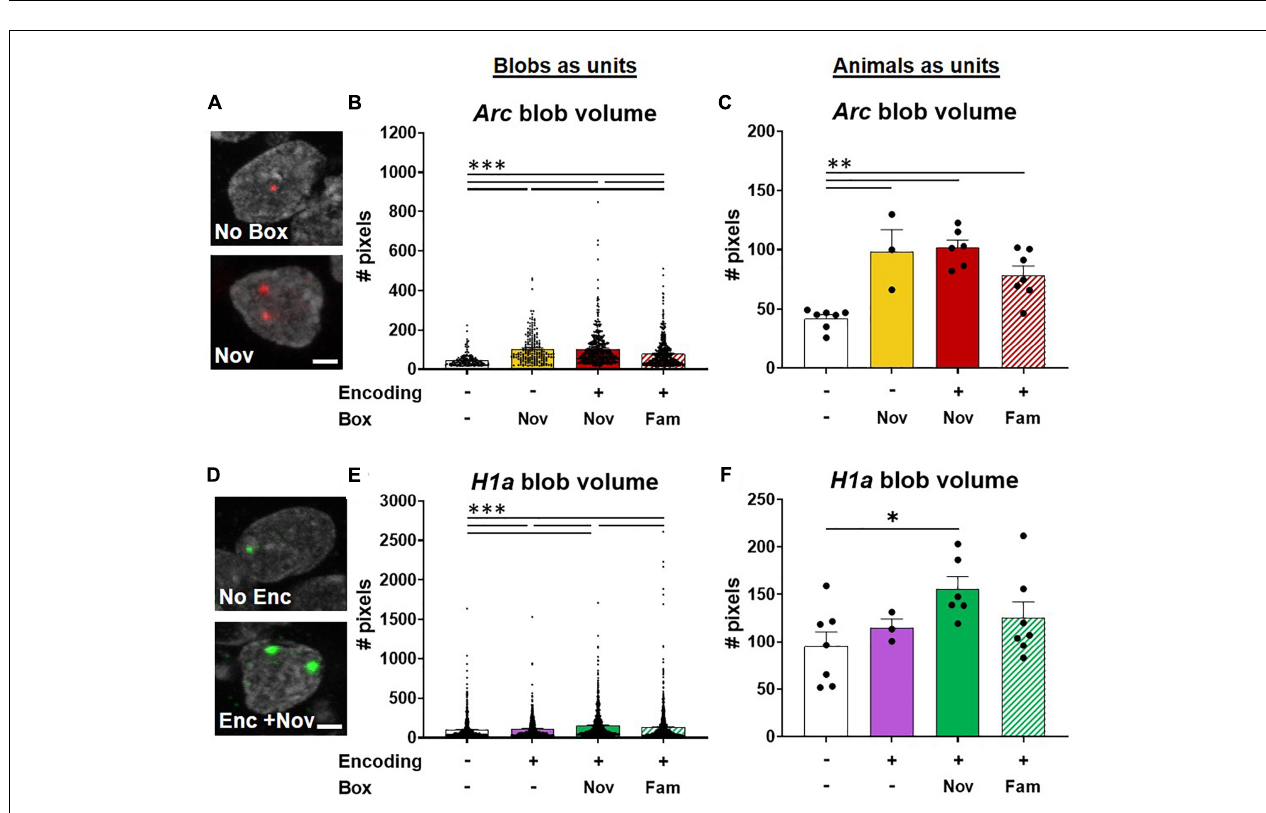
FIGURE 6 | CA1. (E) Correlation between the Arc + only neuronal population activated by box exploration and the overlapping population in proximal CA1. In white: the young rats exposed to familiarity exploration. In black: the young rats exposed to novelty exploration. (Ei) Correlation in the young rats exposed to novelty exploration. (Eii) Correlation in the young rats exposed to familiarity exploration. (F) Correlation between the Arc + only neuronal population activated by box exploration and the overlapping population in distal CA1. In white: the young rats exposed to familiarity exploration. In black: the young rats exposed to novelty exploration. (Fi) Correlation in the young rats exposed to novelty exploration. (Fii) Correlation in the young rats exposed to familiarity exploration. Data are presented as mean ± SEM. ∗∗ p < 0.01.